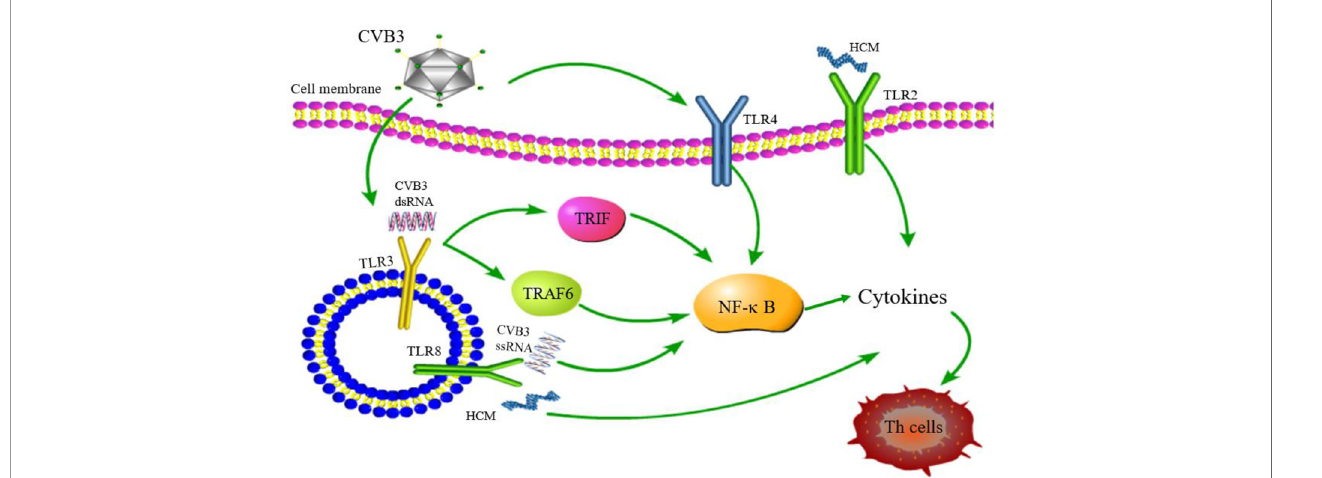
FIGURE 4 | TLR signaling pathway related to CVB3 infection. TLR4/NF- k B is activated after CVB3 infection; TLR3 recognizes CVB3 dsRNA and activates TRIF and TRAF6 to transmit signals to NF- k B; TLR8 recognizes CVB3 ssRNA and activates NF- k B signaling pathway. TLR2 and TLR8 recognizes HCM and promotes the differentiation of Th cells. Although other TLRs may be related to the pathogenesis of myocarditis, whether other TLRs can be activated and its downstream pathway after CVB3 infection has not been